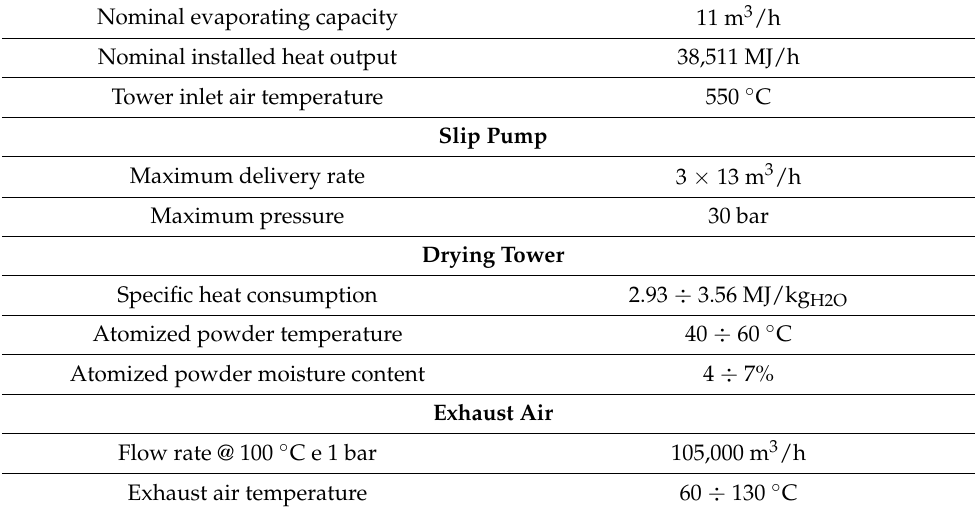
Table 1. Technical data of modelled SACMI ATM 110 spray dryer [41].